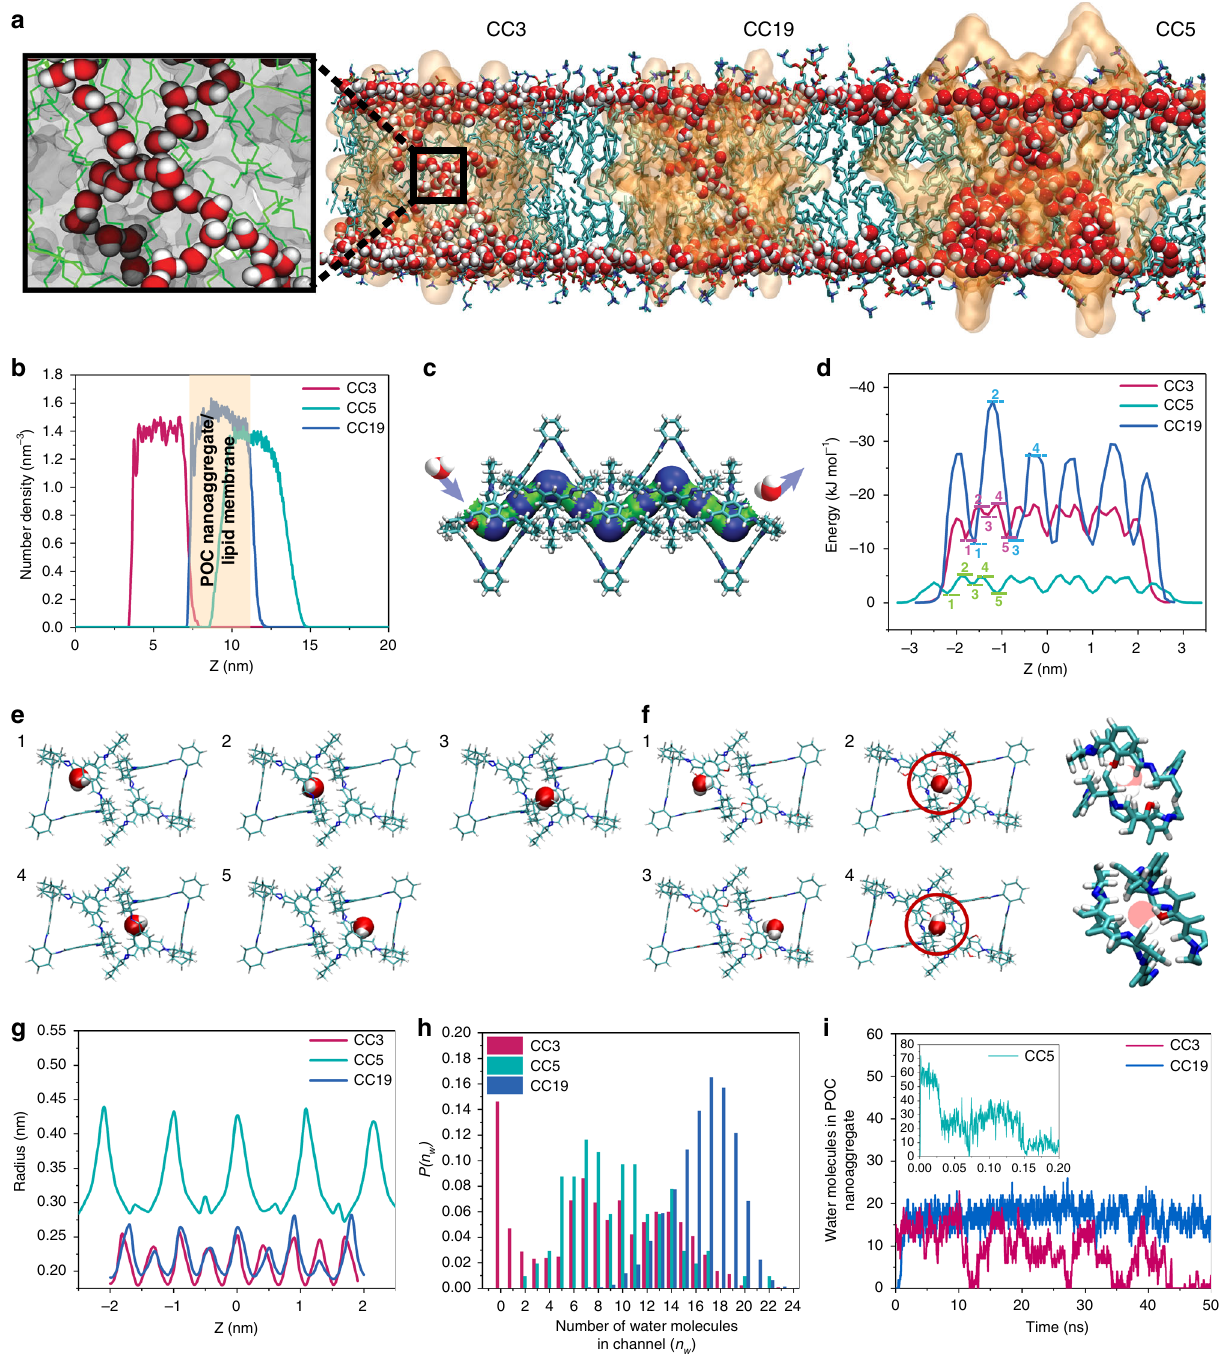
Fig. 4 Molecular simulation of water permeation through POC nanoaggregates embedded within lipid bilayer. a Simulation of water chains formed within the CC3, CC19, and CC5 nanoaggregates embedded within the POPC lipid bilayer. Insert: enlarged water chains inside CC3 nanoaggregate (in transparent gray). b Number density of Na + ions through the lipid bilayer embedded with various POC nanoaggregates. c Scheme of water fl ow through a POC channel. d Interaction energies of water molecules with CC3, CC19, and CC5 channels. Water molecules interact with CC3 and CC5 through a 5-step mechanism ( e ), while through a 4-step mechanism with CC19 because of the presence of hydrophilic hydroxyl groups in CC19 ( f ). g Channel radii of CC3, CC19, and CC5. h Water occupancy ( n w ) probability in CC3, CC19, and CC5 channels. i Wetting and dewetting patterns of CC3, CC19, and CC5